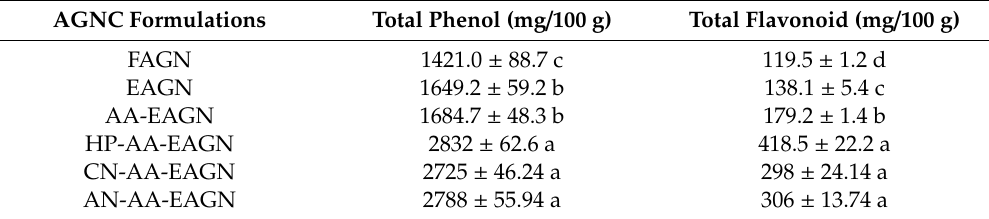
Table 5. Phenolic content and total flavonoid content of the AGNC